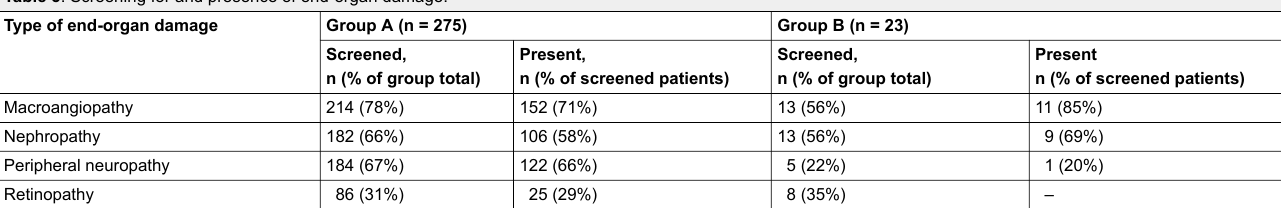
Table 3 : Screening for and presence of end-organ